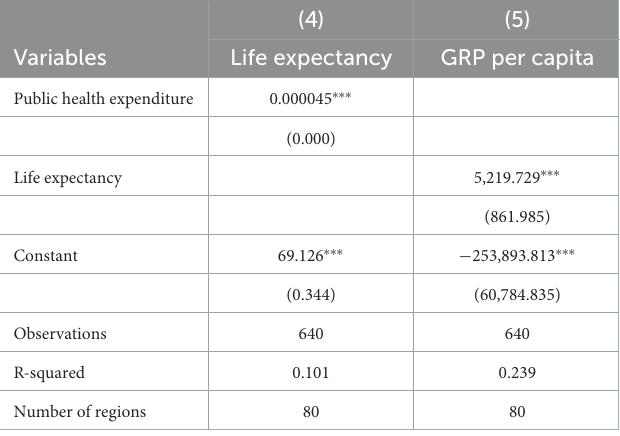
TABLE 3 Calculation of M3 in the fixed effects regression, models 4 and 5,